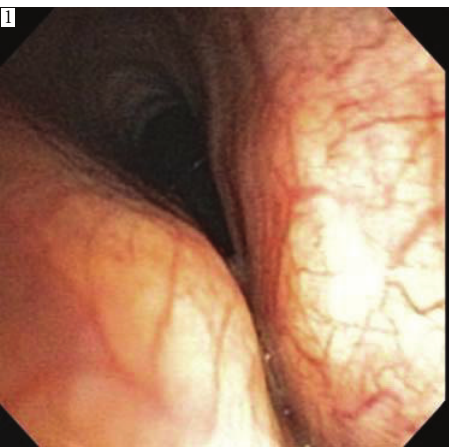
Figure 1: Trachea during bronchoscopic examination demonstrat- ing